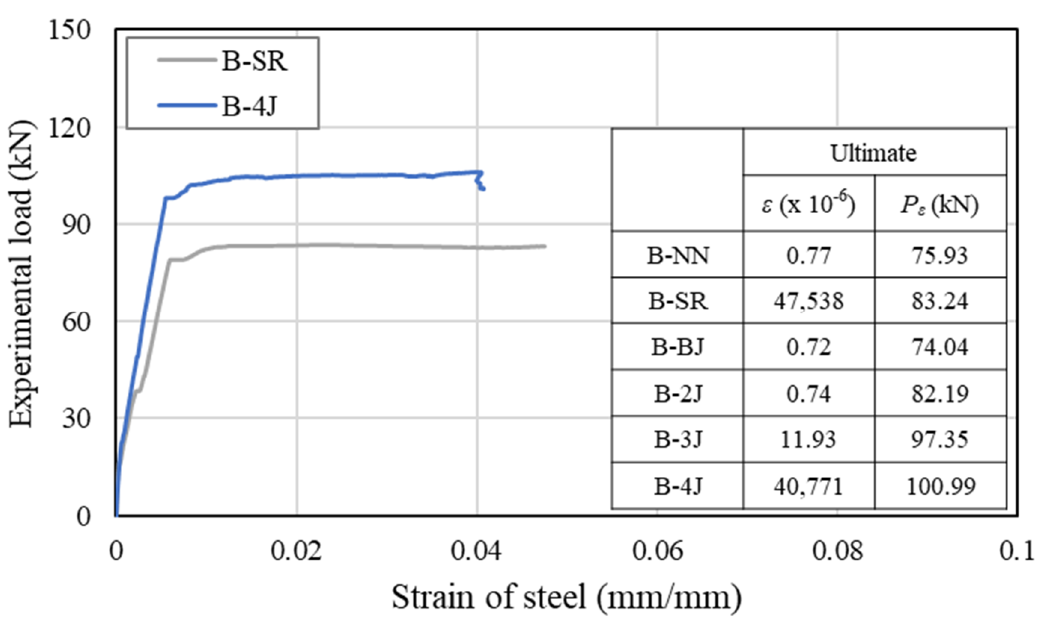
Figure 11. Load–strain of longitudinal steel.